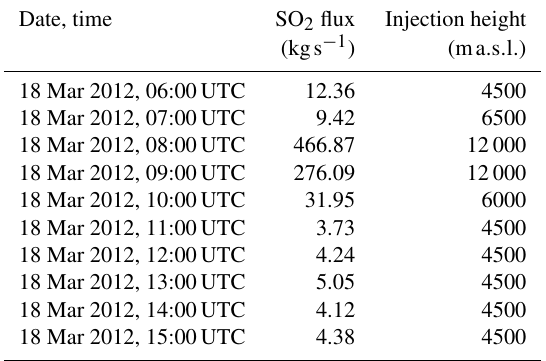
Table 2. SO 2 hourly flux (kgs − 1 ) estimates used as input for the CHIMERE